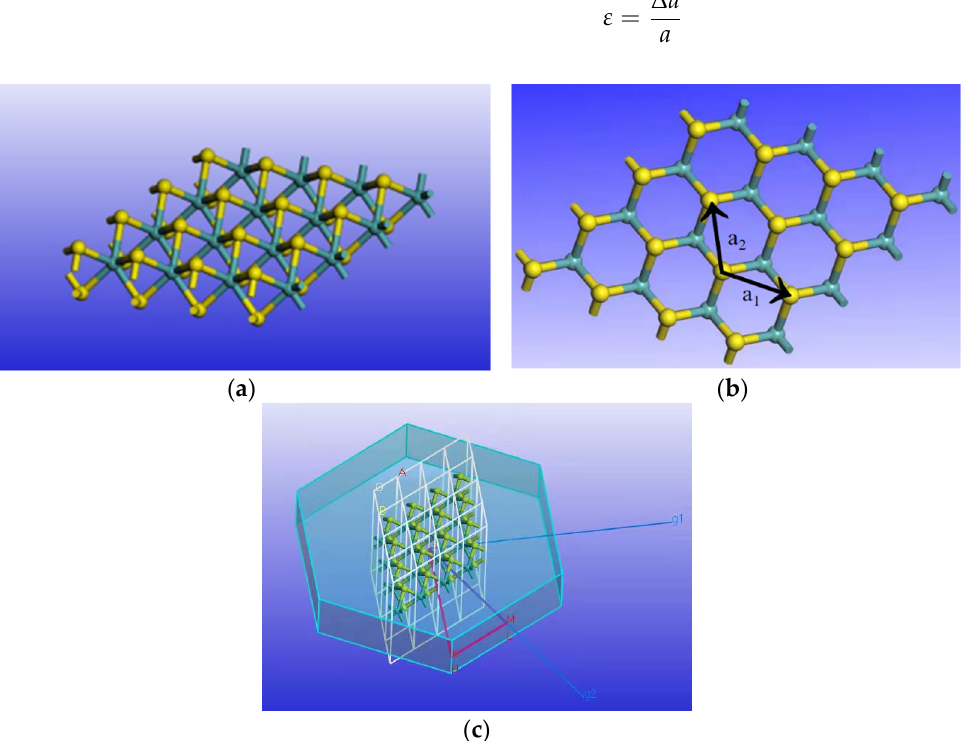
Figure 1. ( a ) Optimized MoS 2 structure, ( b ) the direction of a 1 and a 2 in MoS 2 , and ( c ) the k-point grid in reciprocal space.